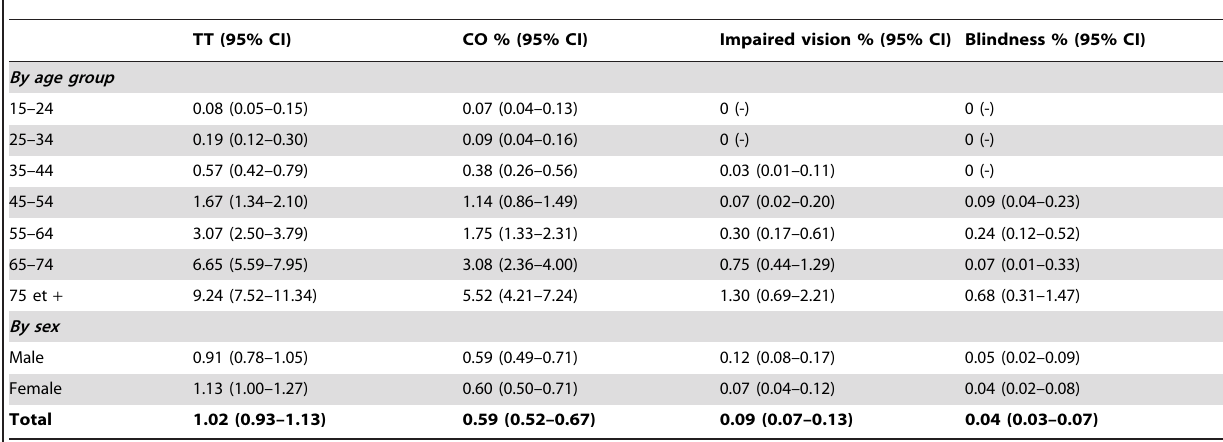
Table 3. Prevalence (%) of TT, CO, impaired vision and blindness due to trachoma in people of $ 15